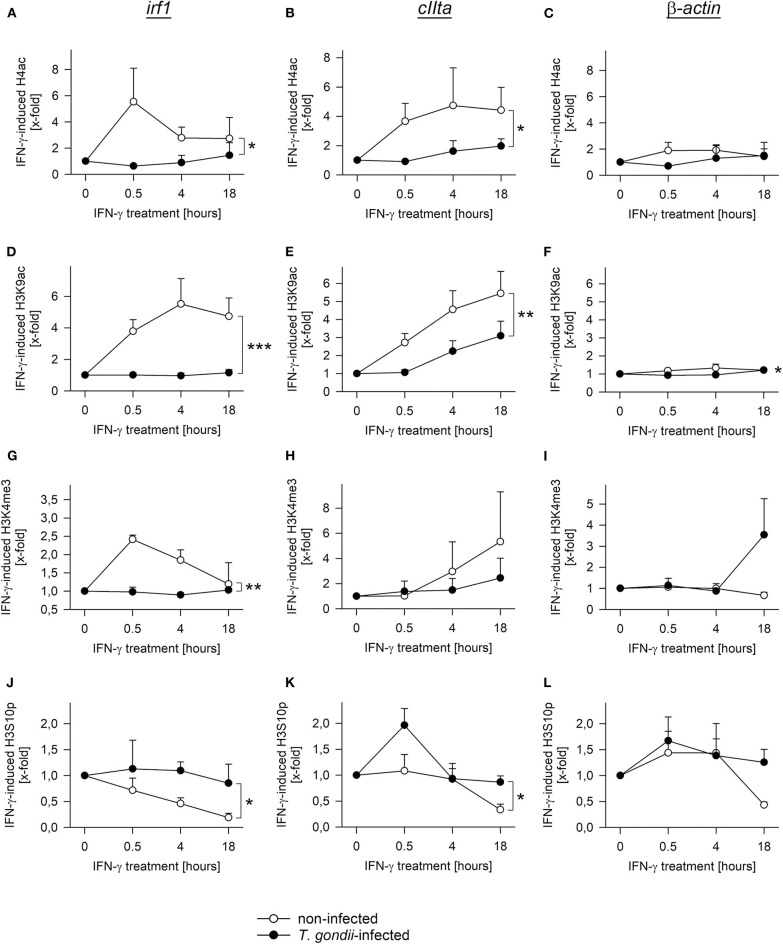
T. gondii largely abolishes regulation of diverse histone modifications during IFN-γ stimulation of RAW264.7 cells. Cells were parasite-infected for 24 h or were left non-infected. During the final 0.5–18 h, they were stimulated with IFN-γ or were left unstimulated (0 h). After cross-linking DNA-protein complexes, cell lysates were subjected to ChIP using antibodies binding to pan-acetyl-H4 (A–C), acetylK9-H3 (D–F), tri-methylK4-H3 (G–I) or phosphoS10-H3 (J–L). After isolation of DNA from chromatin immunoprecipitates or from input chromatin, fragments of promoters of irf1
(A,D,G,J), cIIta (pIV; B,E,H,K) and β-actin
(C,F,I,L) were amplified by qPCR. Data indicates means ± S.E.M. (two to six biological replicates) of cytokine-induced regulation of histone modifications in T. gondii-infected (closed symbols) and non-infected (open symbols) cells normalized to input DNA; differences between experimental groups were identified by ANOVA (*p < 0.05; **p < 0.01; ***p < 0.001).